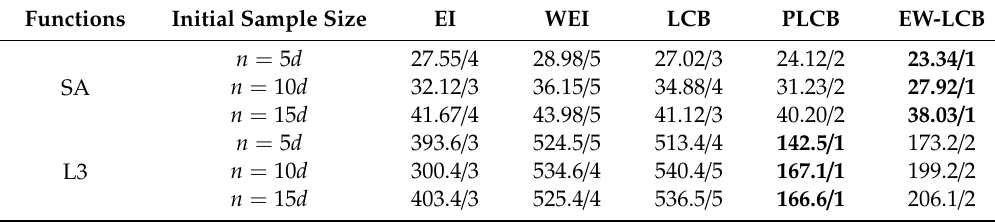
Table 6. Results of di ff erent initial sample points for functions SA and